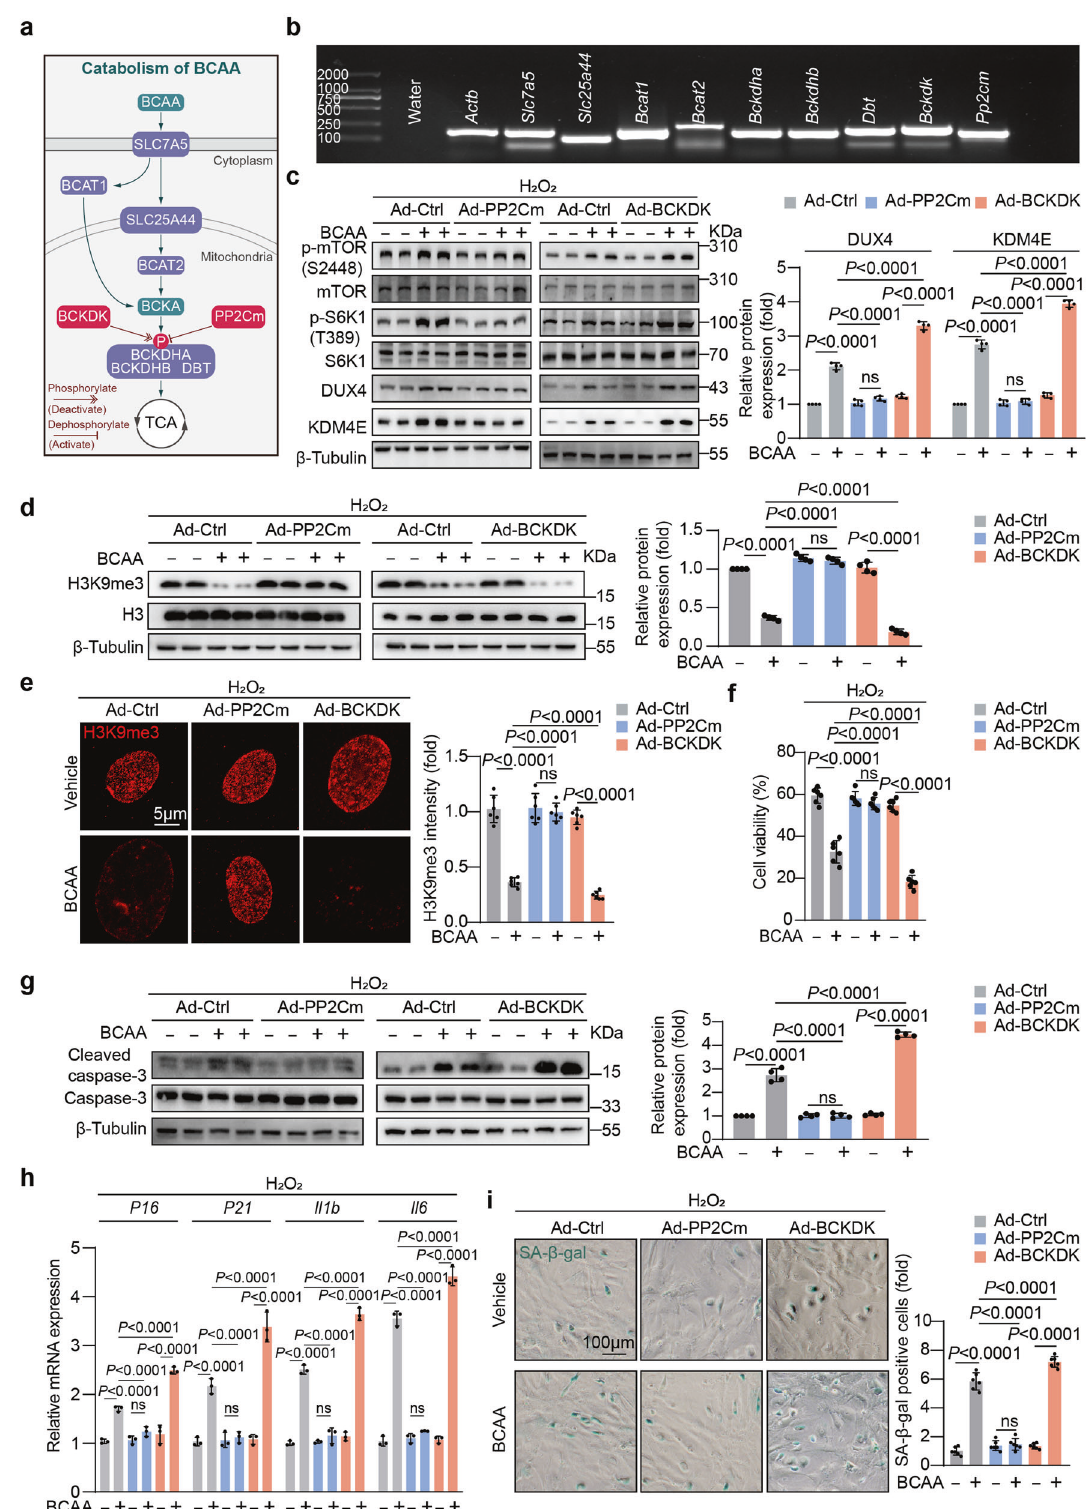
Passage 2 ADSCs were used in the present study. ADSCs (2 × 10 5 ) dially injected at three different sites in the peri-infarct zone immediately after ligation of the coronary artery. Sham group Signal Transduction and Targeted Therapy (2022)